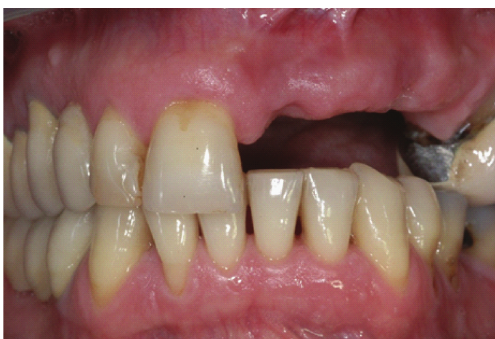
Figure 1: Frontal view of maxillary anterior zone: loss of vertical bone in the edentulous space with loss of papillae and altered profile of alveolar